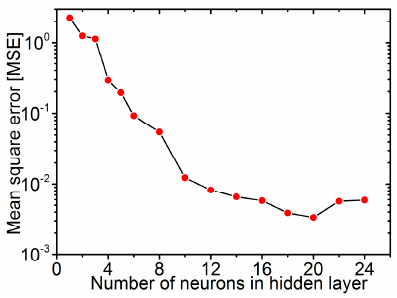
Figure 6 . Dependence of the mean Square error versus number of neurons in the hidden layer.